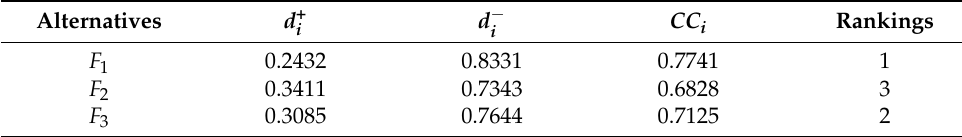
Table 14. Rankings of the alternative designs.